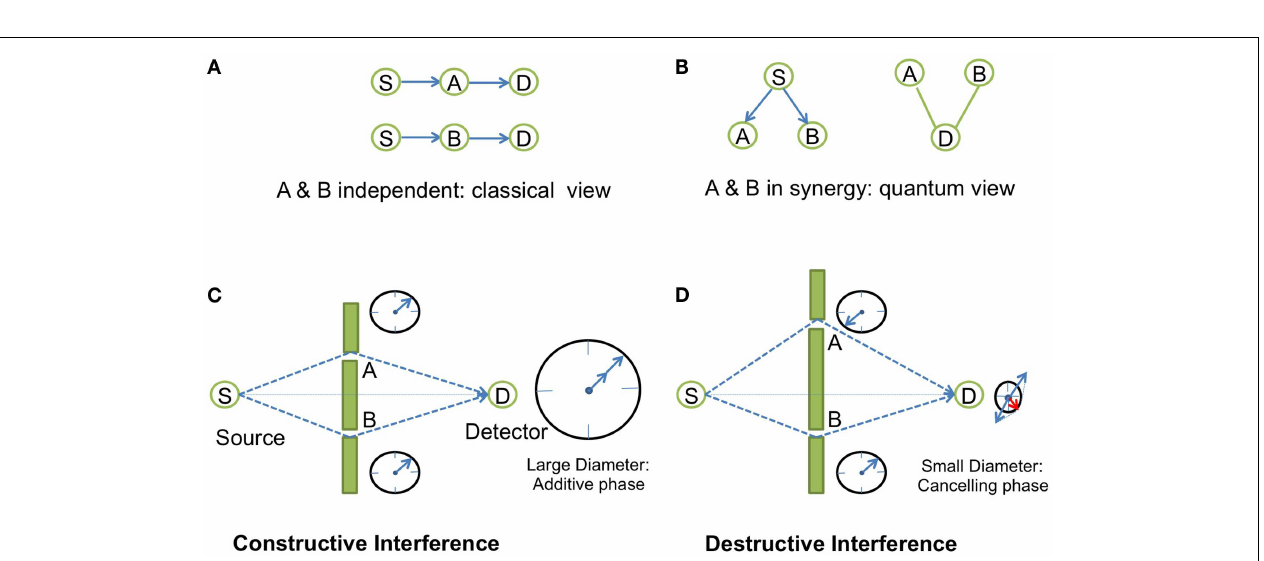
where (cid:104) . (cid:105) is the amplitude of probability of the event. (C) The probability of the total event will correspond to an amplified synergistic effect if the two arrows of the two independent events points toward the same direction, i.e., if the photons are in phase between each other which occurs when the difference between the two trajectories corresponds exactly to an integer number of time period difference between the two photons.This is symbolically represented by a “watch clock” for each photon that turns with a specific speed depending upon the frequency of the light. If the arrows of these two watches point toward the same direction, then the photons are in phase, and we get constructive interferences. (D) Destructive interference is observed when the arrows are in the opposite direction (opposite